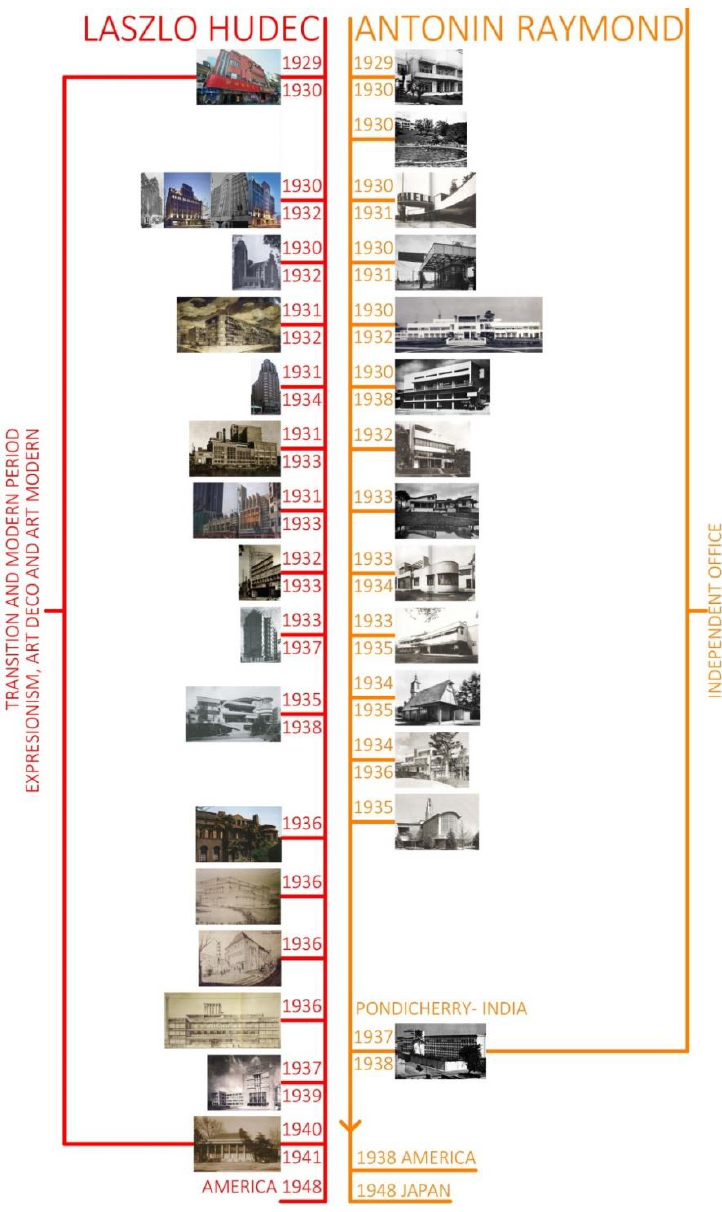
Figure 4. Timeline 03 — Hudec and Raymond comparative designs.